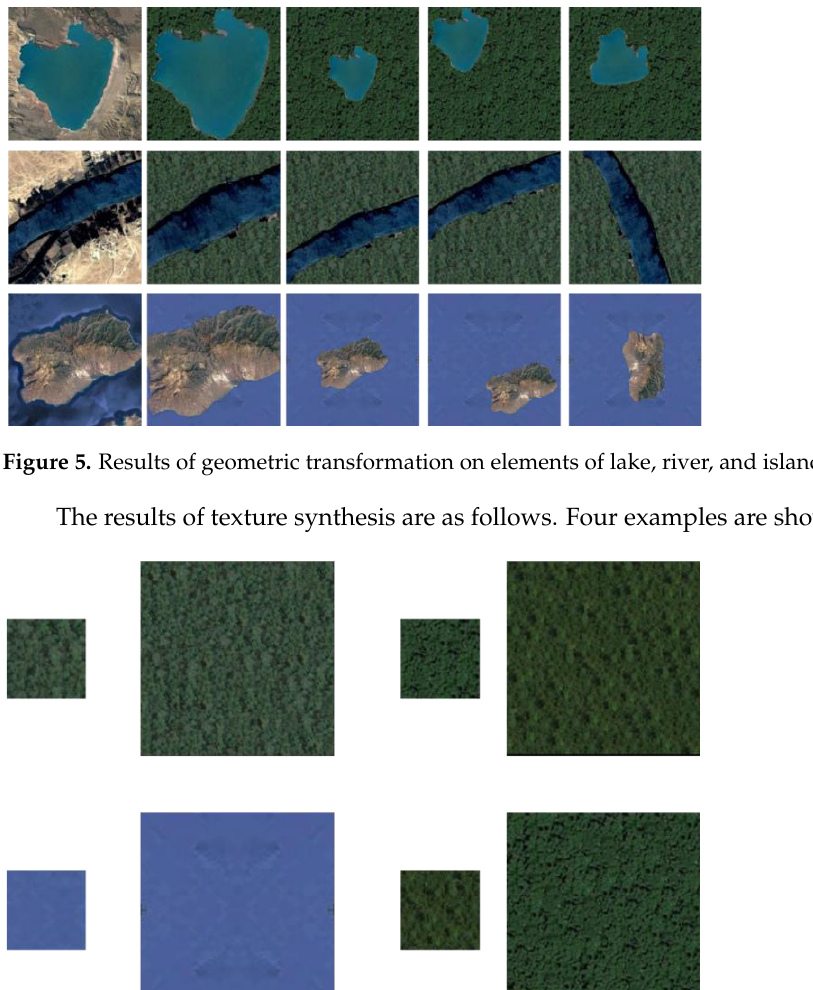
Figure 7. Generation results of GANs and our method. We compared images generated by our method with the image generated by the con- ventional GAN network. It may be observed that for most images generated by the GAN network, there are problems with blur and distortion. In the ACGAN network generation experiment, there was a significant gradient-vanishing issue, and the model did not